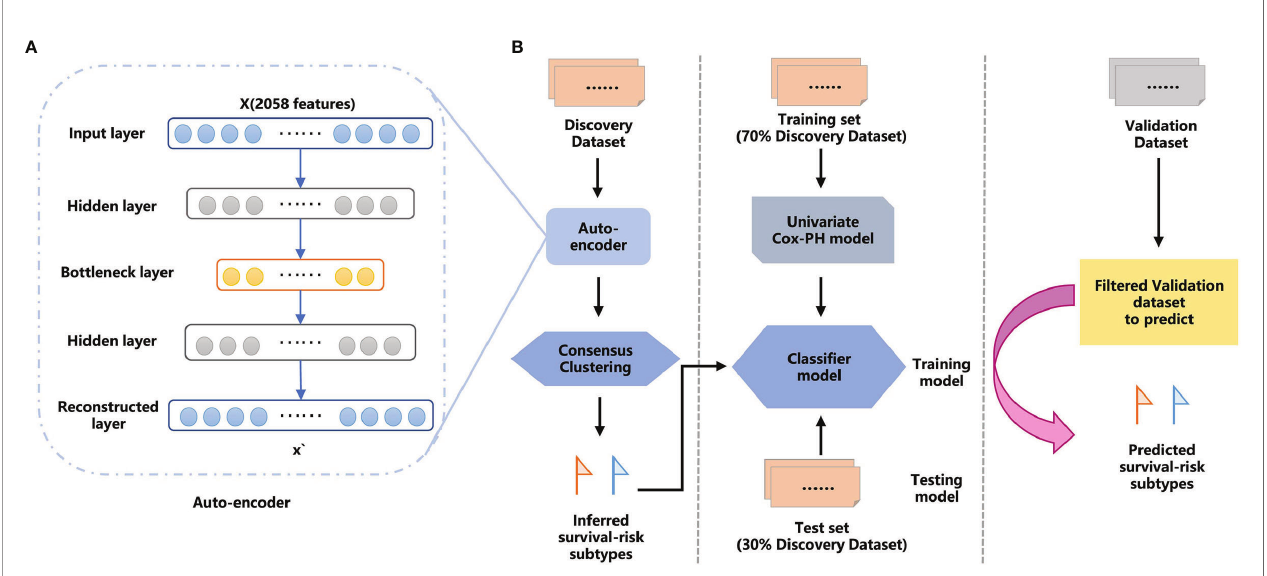
FIGURE 1 | The overall work fl ow for GC proteomic molecular subtyping based on DL AE framework features extraction. (A) AE framework. (B) Work fl ow combining DL and machine learning (ML) methods to predict GC survival-risk subtypes. The work fl ow includes two steps: step 1, inferring survival-risk subtypes in the discovery set; and step 2, predicting survival-risk labels for samples in the independent validation